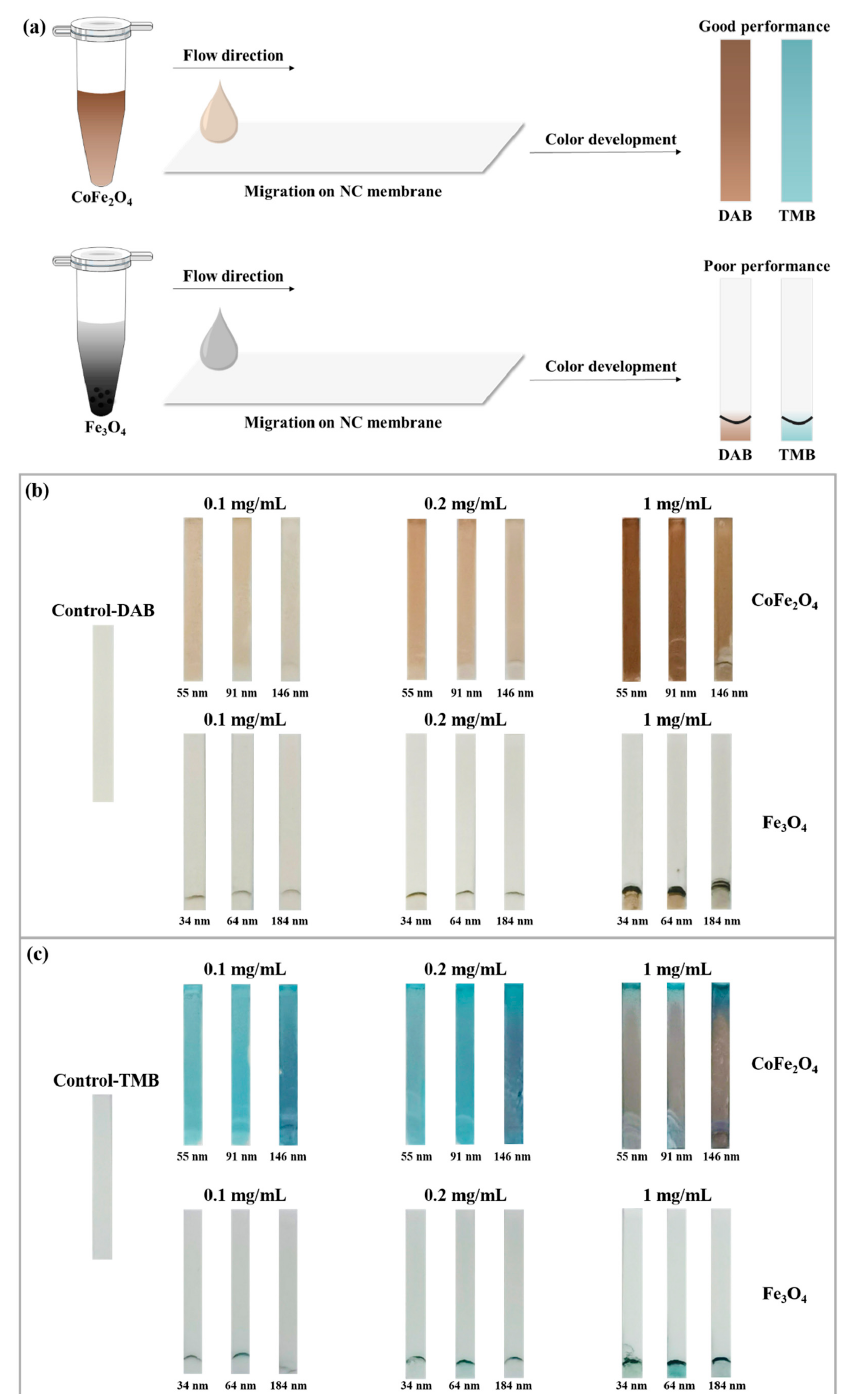
Figure 3. In situ color development of nanozymes on NC membrane. ( a ) A comprehensive scheme of the experimental process and result evaluation. ( b ) Exhibition of nanozymes on NC membrane by DAB substrate solution. ( c ) Exhibition of nanozymes on NC membrane by TMB substrate